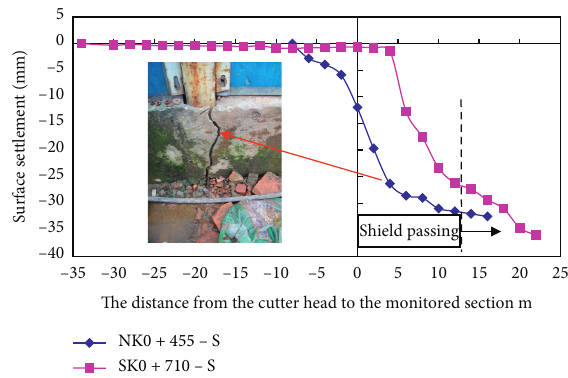
Figure 8: Curves of shield driving velocity as the shield passed under the embankment.